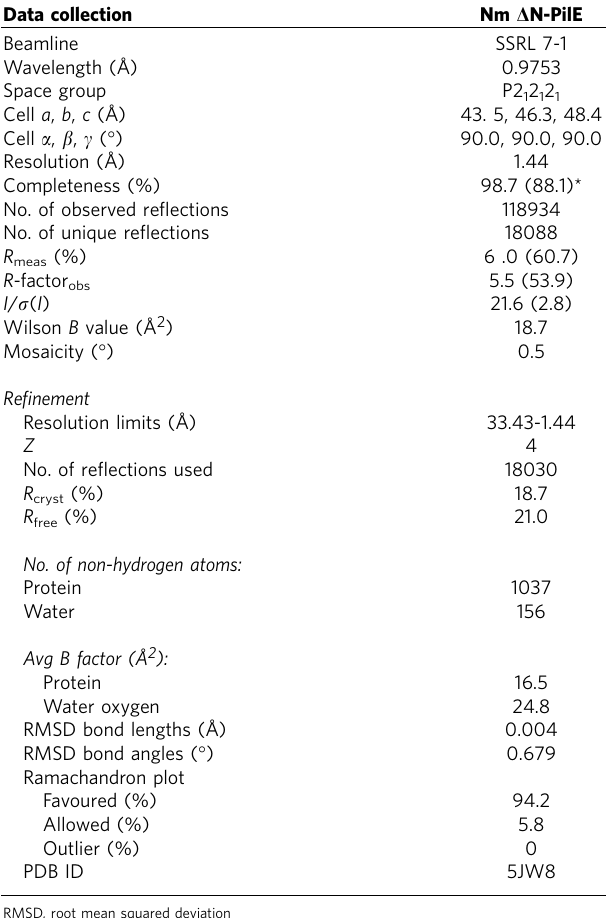
Table 1 | Nm D N-PilE data collection and refinement